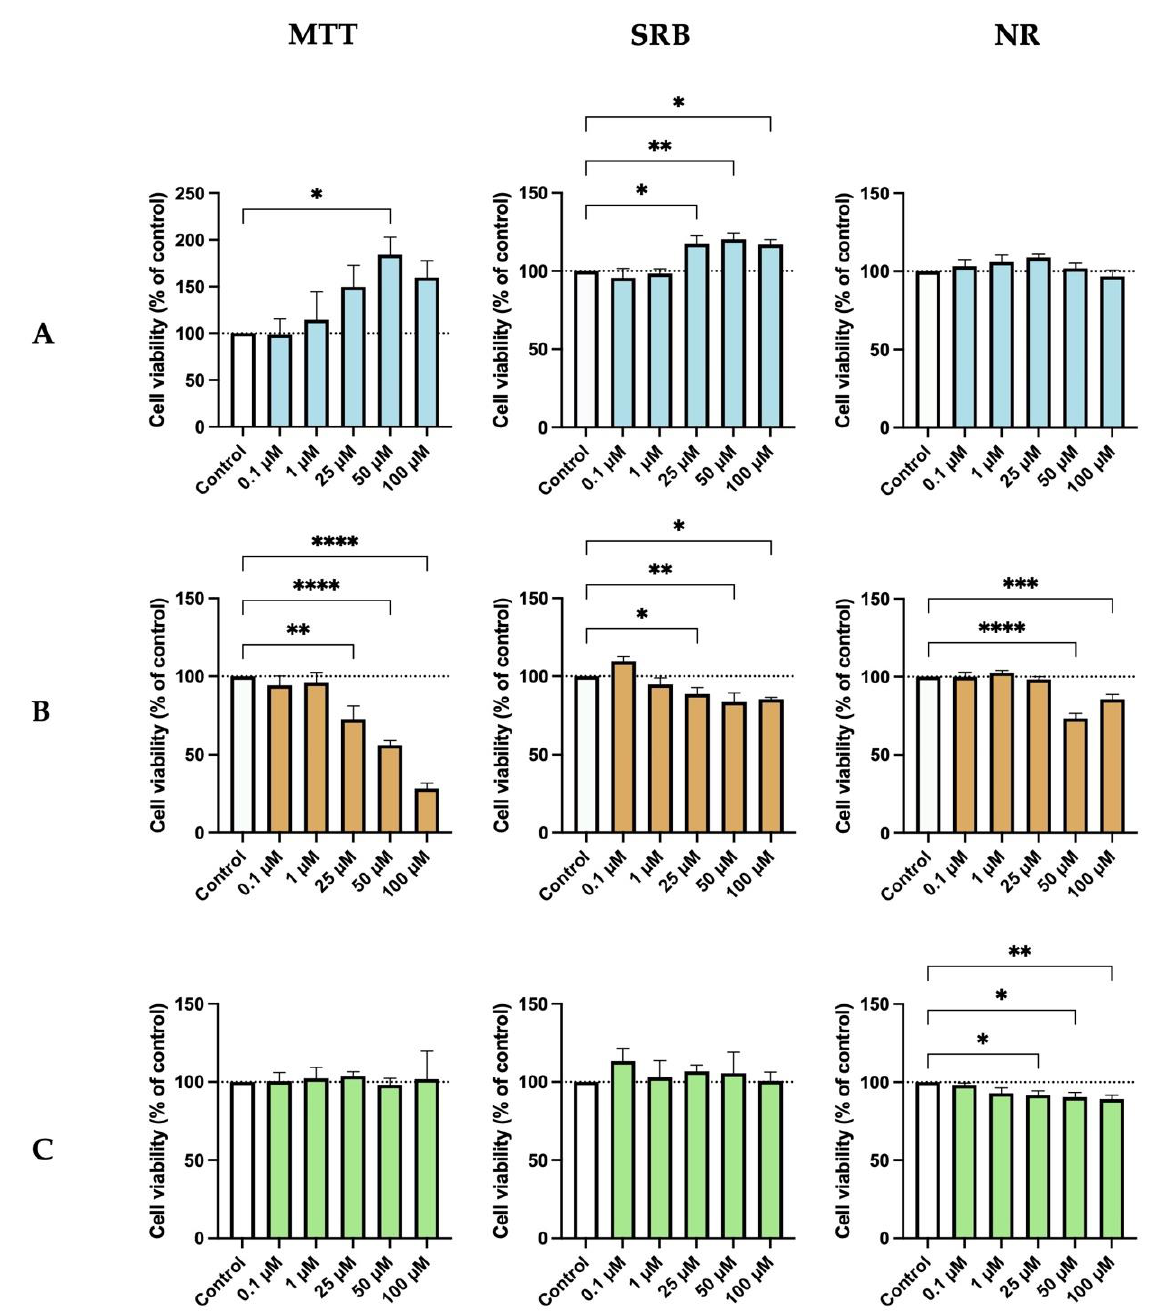
Figure 2. Effects of ( A ) Edaravone, ( B ) Perampanel, and ( C ) Metformin treatment on HT-22 cells viability, evaluated by three different assays. Protein content and cell viability were assessed by SRB (middle panel) and MTT and NR (left and right panel) assays, after 48 h of exposure. Results are expressed as the percentage of cell viability relative to the respective untreated control cells. *, **, ***, and **** indicate p < 0.05, p < 0.01, p < 0.001, and p < 0.0001, respectively, when compared to control. All data are presented as the mean + SEM of three independent experiments.